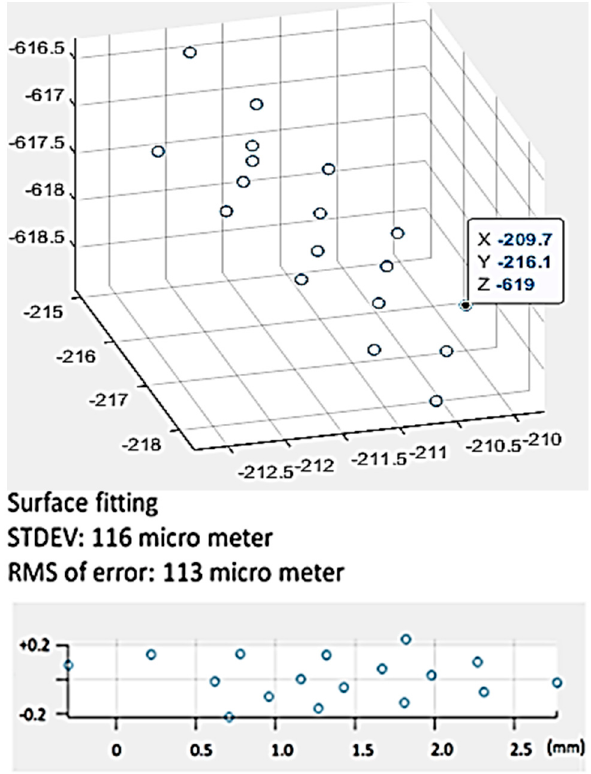
Figure 14. 3D modeling accuracy of a surface ( × 30).